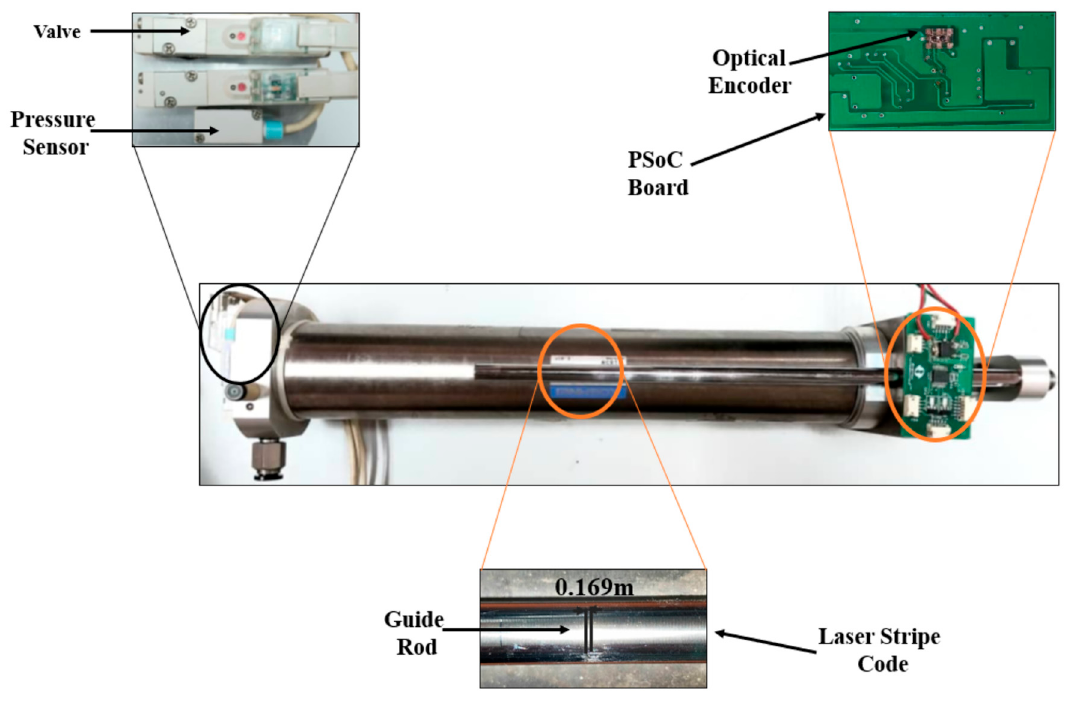
Figure 1. IPA components.